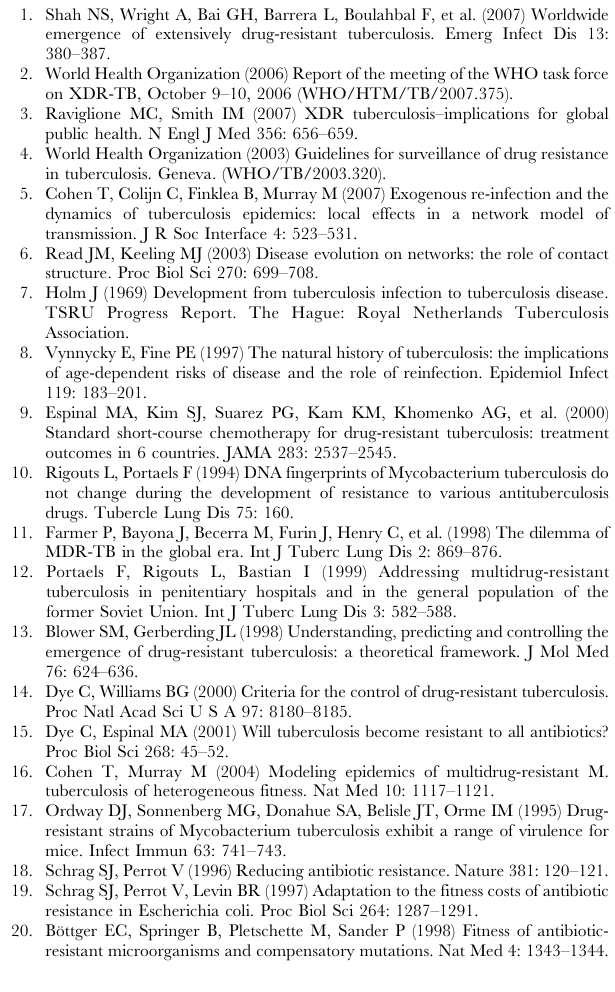
drug-resistant; yellow, mixed). The relative heights of the red and green bars depend on the respective relative fitness of resistant and sensitive strains. Each of these hypothetical individuals is shown to suffer at least one re-infection event to demonstrate that the probability of progression to disease is lower after re-infection than it is for a primary infection, reflecting partial immunity conferred by a previous